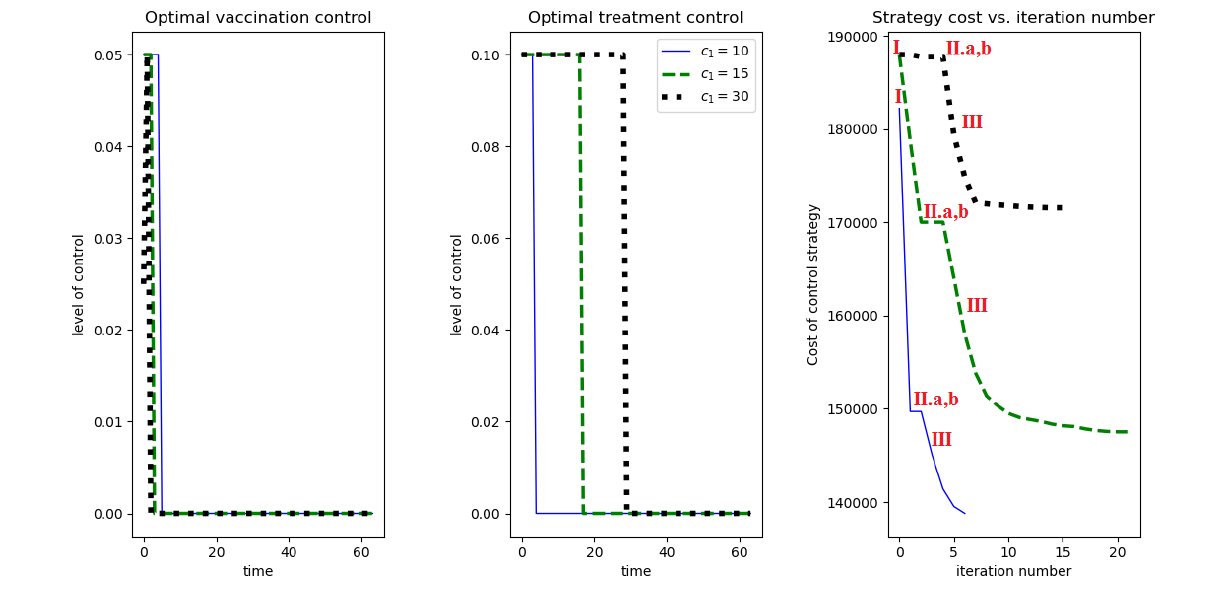
Figure 9. Optimal vaccination, treatment controls and strategy cost for different values of c 1